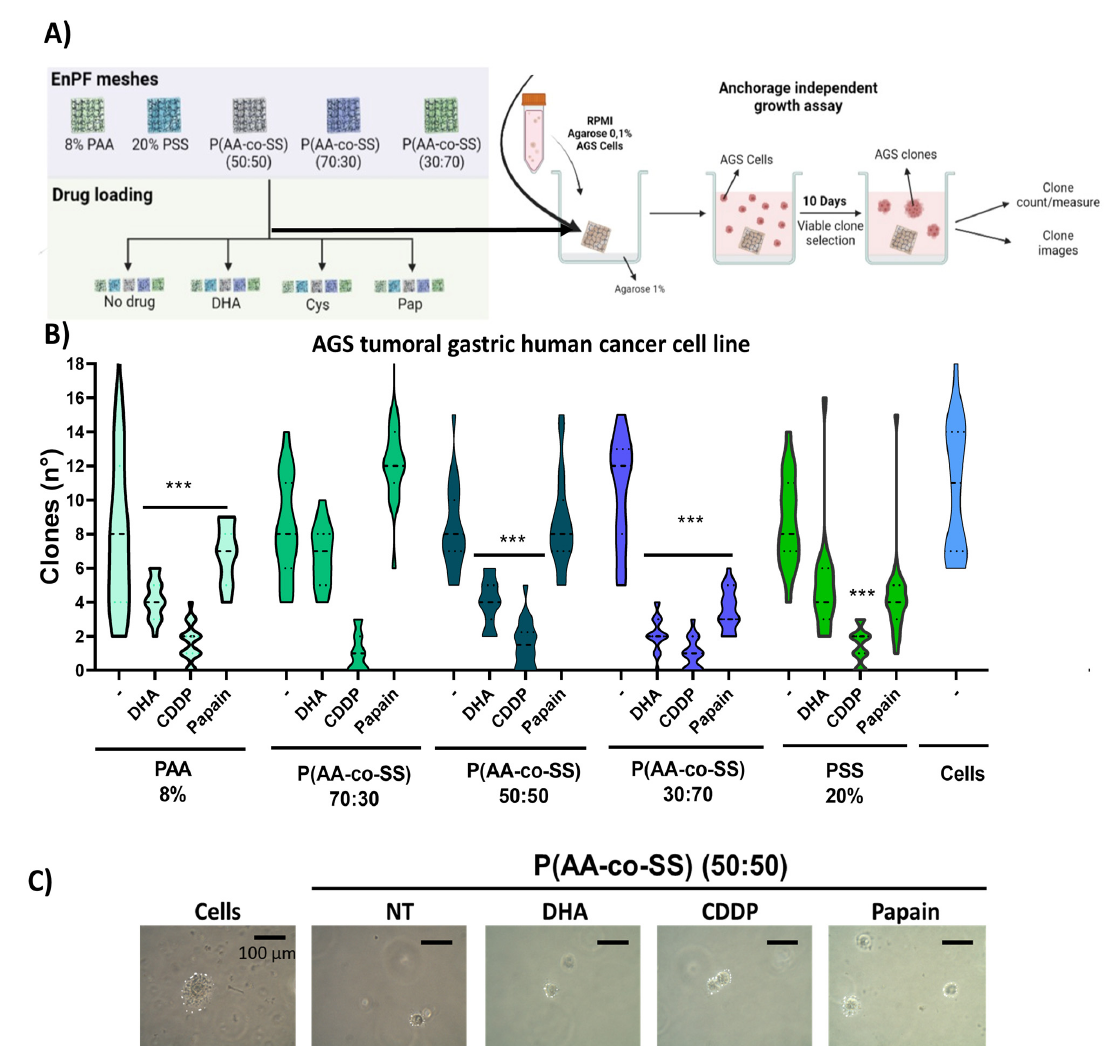
Figure 9. Anchored-independent cell growth assay of gastric AGS tumoral cells in the presence of EPnF mesh charged with chemotherapeutic/adjuvant drugs. ( A ) Experimental design for evaluating the anchorage-independent growth ability of tumoral cells in each EPnF mesh. ( B ) The total number of clones at 10 days, in which AGS cells cultured with 8% PAA, P(AA- co -SS) (70:30), P(AA- co -SS) (50:50), P(AA- co -SS) (30:70), and 20% PSS. EPnF meshes were charged with 50 µ M of DHA, 100 µ M of CDDP, and 1.5 µ g/mL of Pap. The graph showed the total number of clones formed and representative optical images from clonogenic assays under each condition. The amplification bar represents 100 µ m ( n = 3, *** p < 0.001), ( C ) representative AGS tumoral cells are growing clones in the soft